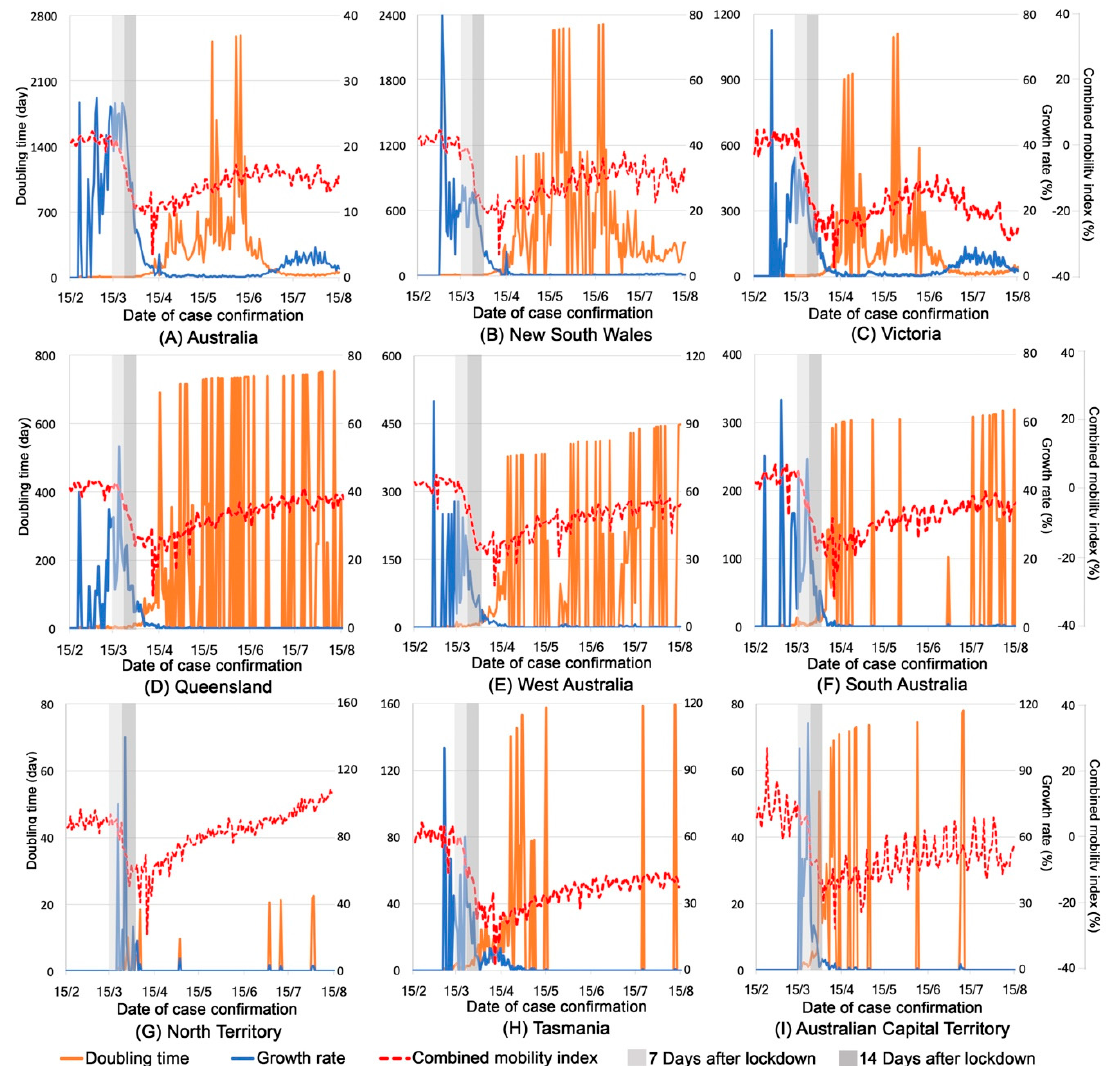
Figure 4. Combined mobility index, growth rates, and doubling time in each Australian state / territory. Note: In each graph, Y -axis on the left denotes doubling time (day); Y -axis on the right denotes growth rates (%); A combined mobility index is shown on the Y -axis on the right of each row. The correlation coefficients between CMI and growth rates in the first wave (15 March to 15 June) are significantly ( p < 0.01) positive in most states except the Northern Territory (Figure 5A), indicating that a higher level of mobility is associated with a higher level of growth rates. The magnitude of correlation coefficients in most states increases from the period right after lockdown to